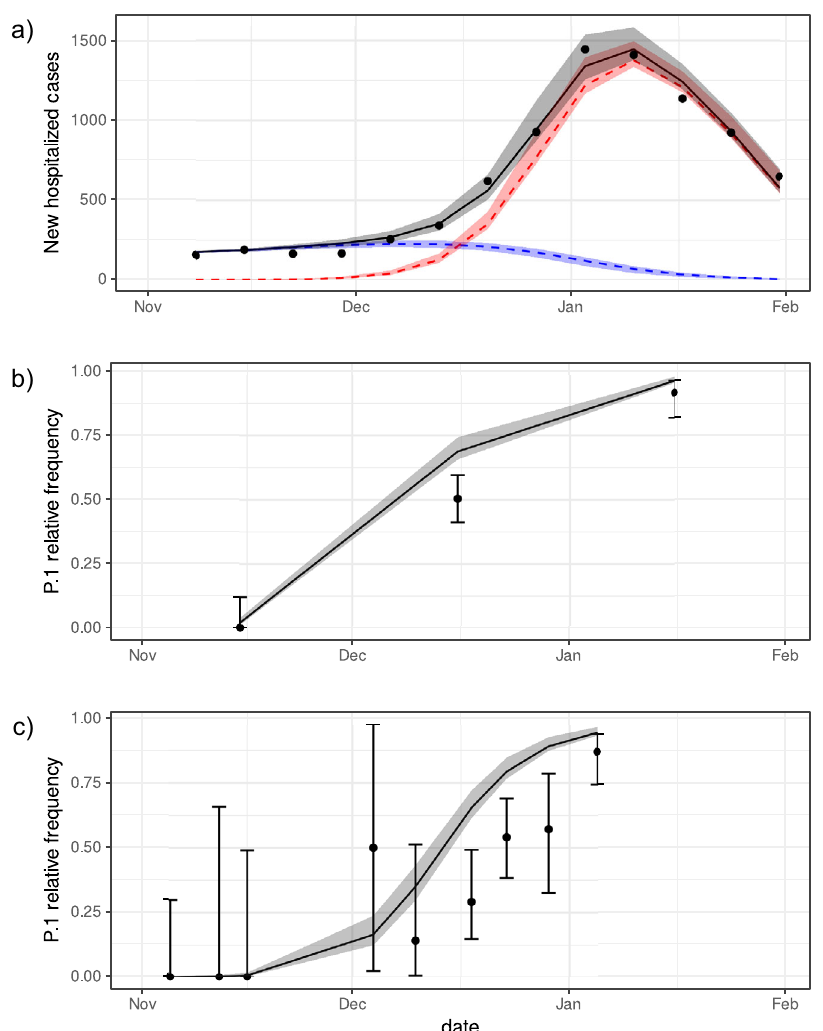
Fig. 2 Hospitalization cases and frequency of the P.1 variant in Manaus city. a Weekly new hospitalized COVID-19 cases in Manaus city. Grey line represents the fi tted values of total cases (all variants) by maximum likelihood estimation (MLE) of the parameters. Red and blue lines represent the predicted values of cases due to P.1 and wild-type variants, respectively. Black dots are nowcasted observed data of hospitalizations. Panels b, c show the fi ttings to the time-series frequency of P.1 on datasets provided by previous works, which were aggregated monthly 13 and weekly 3 , respectively. The area around the lines indicate the 95% CI of the expected values. Dots and lines are the sample proportions of P.1 in sequenced genomes, and their 95% sample CI. The fi tted values of the model parameters are presented in Table